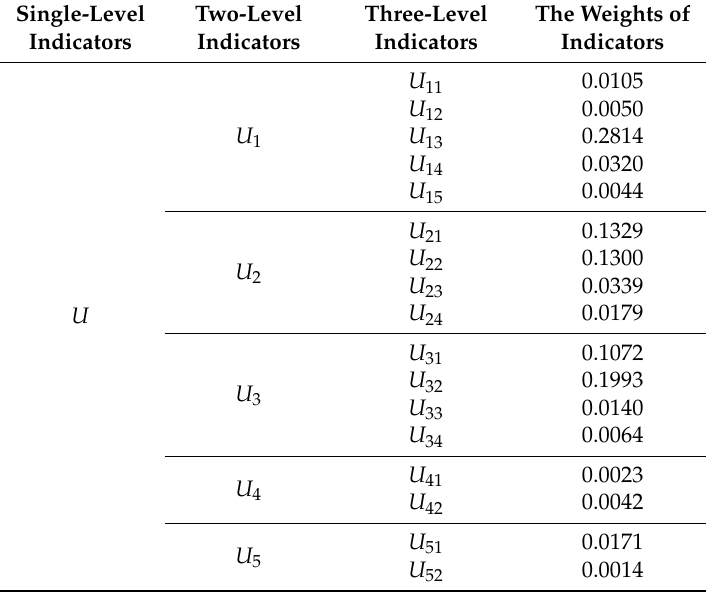
Table 6. Objective weights of energy saving and emission reduction evaluation indicators of electricity retailers.